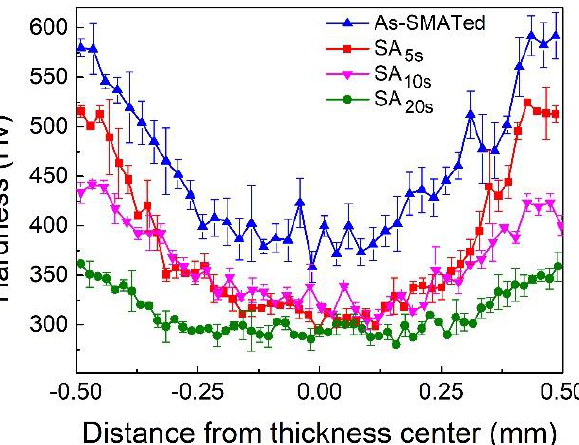
Figure 4. Cross-sectional hardness distribution of as-SMATed and SA x s gradient samples.